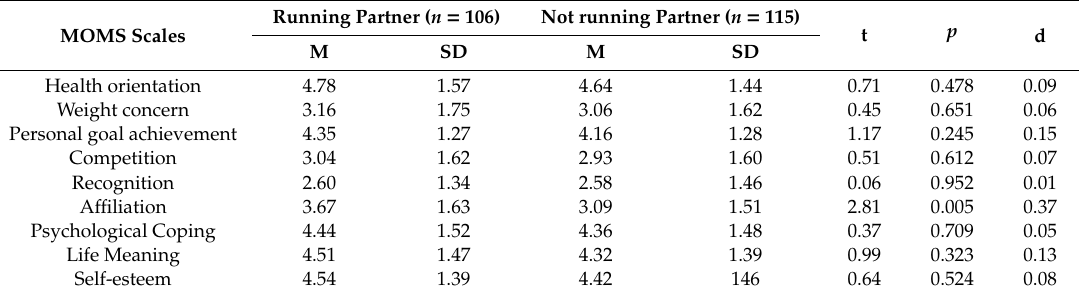
Table 7. Motives of runners who run with partner and without partner.